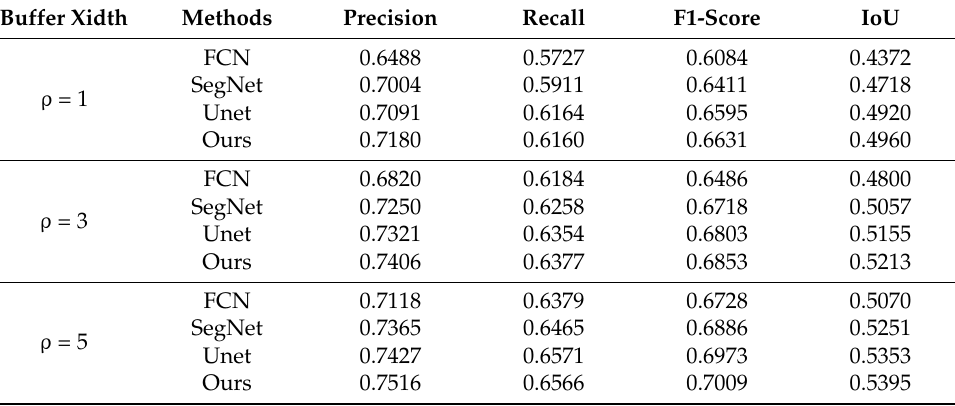
Table 3. Experimental results of road centerline extraction with different networks under different buffer widths ( ρ ).